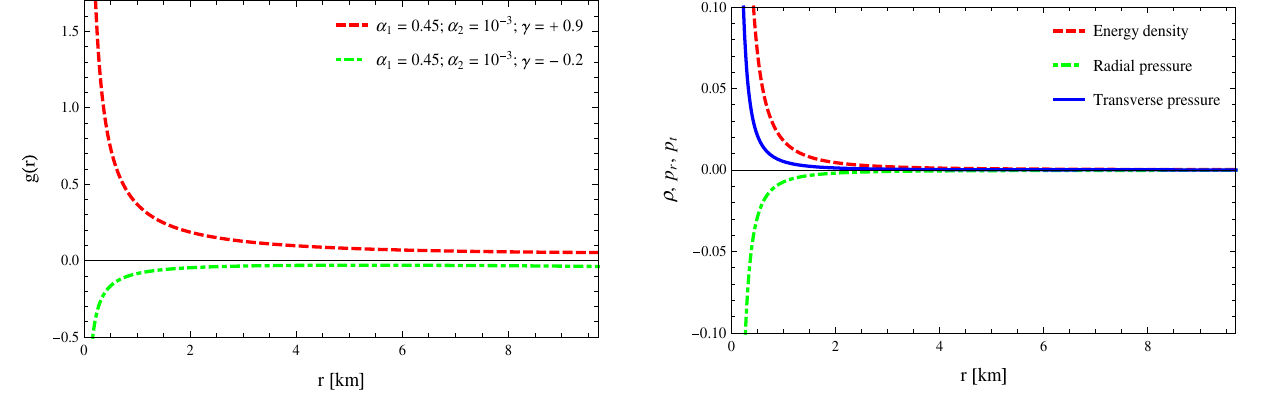
Fig. 2 Variation of the matter density ρ , radial pressure p r and trans- verse pressure p t with the radial coordinate of the DE model for spher- ical object PSR J1614-2230